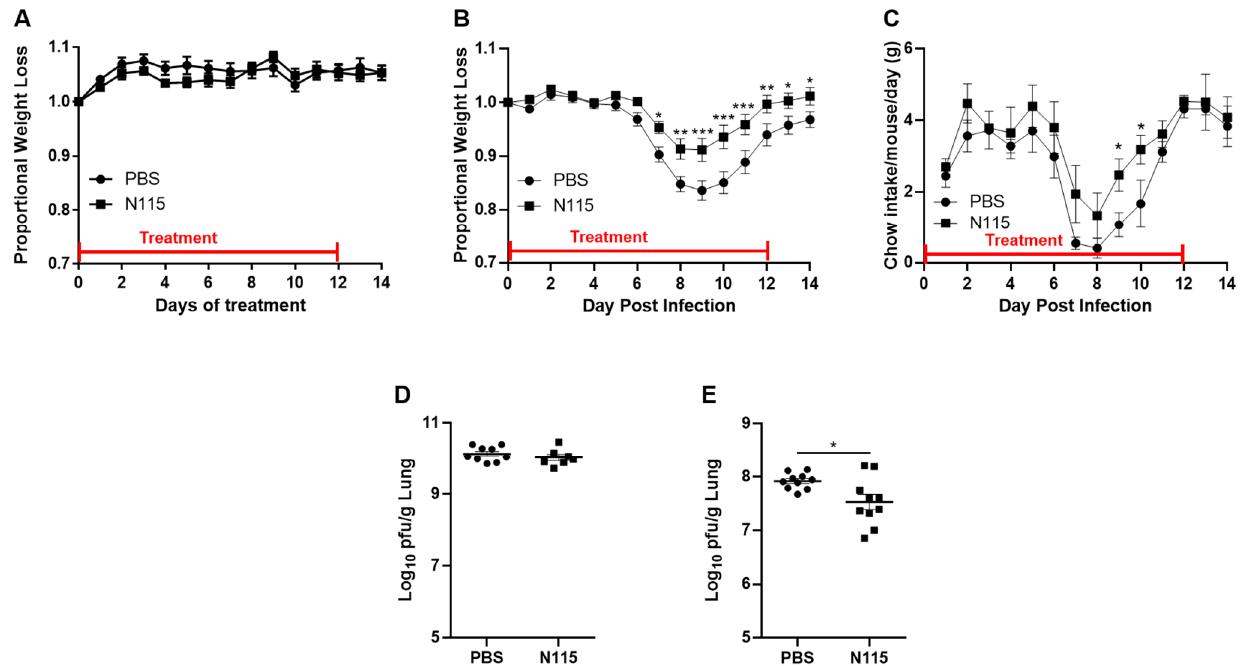
Figure 3. Nebulized N115 improves weight loss and virus titer in mice infected with IAV. WT C57BL/6J mice were treated with either nebulized 20 mM NaPyr (N115) or nebulized PBS as control 3 times a day for 20 min/treatment to test for toxicity ( A ). WT C57BL/6J mice were infected intranasally with 250 PFU of influenza A/PR/8/34 H1N1. Mice were treated with either nebulized 20 mM NaPyr (N115) or nebulized PBS as control 3 times a day for 20 min/treatment. ( B ) Mice were monitored daily for 14 days to determine weight differences between treatment groups. ( C ) Average chow intake over the 14-day IAV infection of both N115 treated and PBS treated mice. ( D , E ) Viral titer was assessed by plaque assay on day 3 ( D ) and day 7 ( E ) p.i. from lung homogenates. Weight loss and chow intake data are representative of 3 independent experiments with n = 4–6 mice per treatment group per independent experiment. Viral titer data are representative of 2 individual experiments with 3–5 mice per treatment group per individual experiment. Statistical significance was determined using a Two-way ANOVA with Fisher LSD post-hoc for multiple comparisons, and Student’s t -test for single comparisons. * p < 0.05, ** p < 0.01, *** p < 0.001.